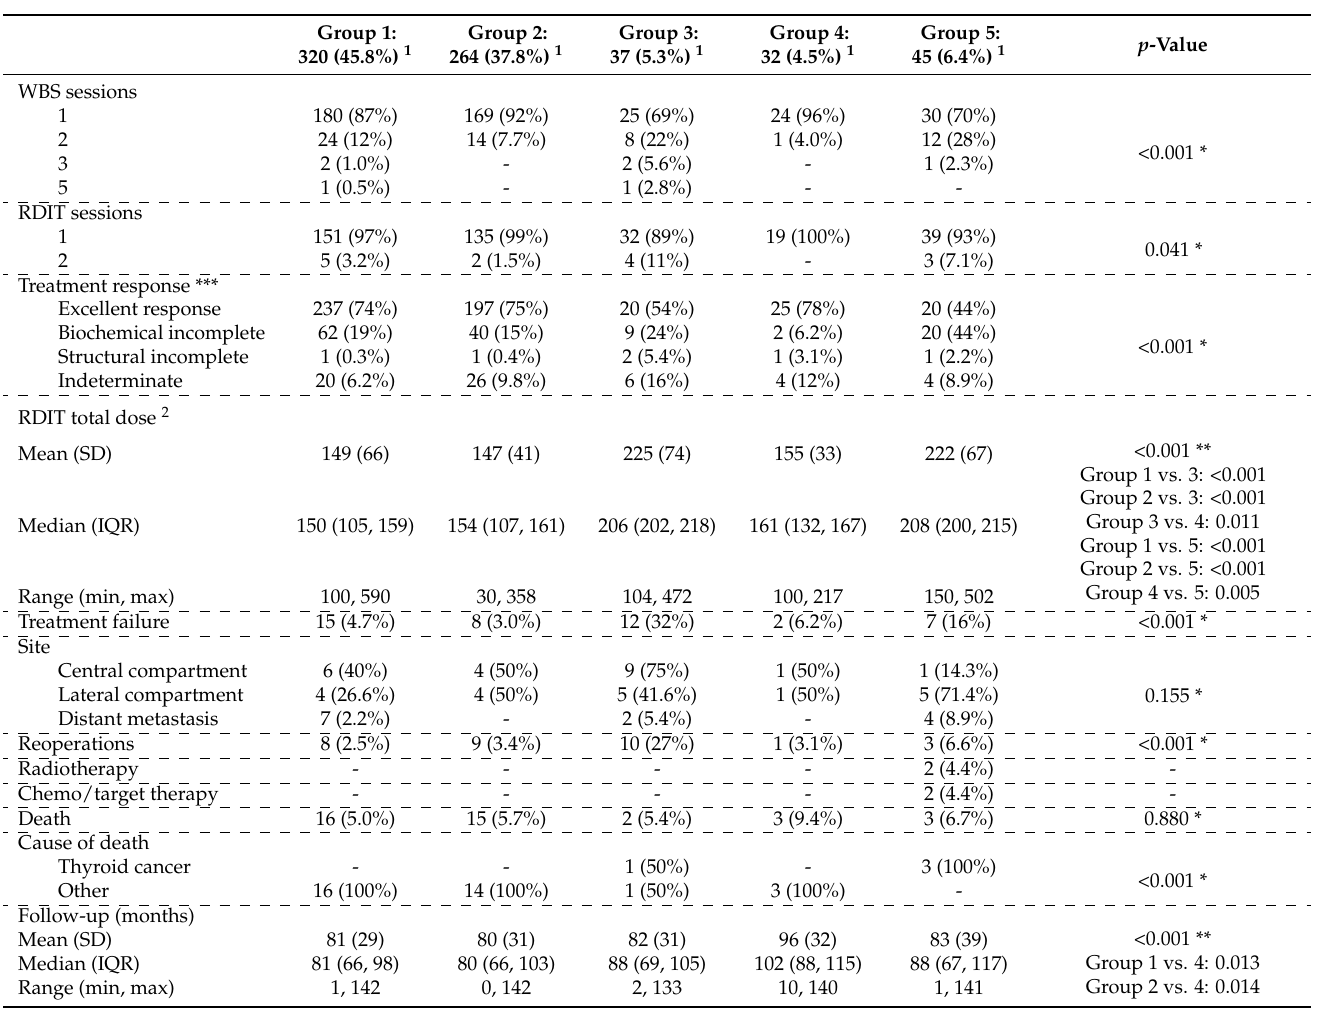
Table 4. Follow-up characteristics and